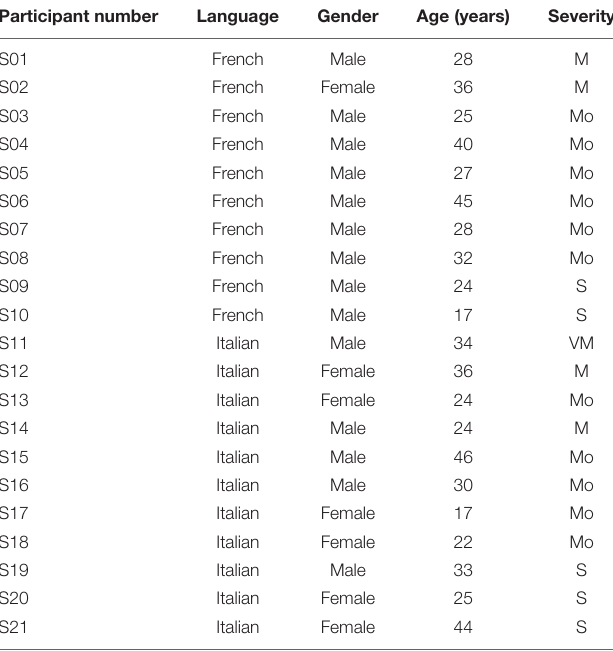
TABLE 2 | Language, Gender, Age, and Stuttering Severity [according to SSI-3: Very Mild (VM), Mild (M), Moderate (Mo), and Severe (S)] for each PWS. Participant